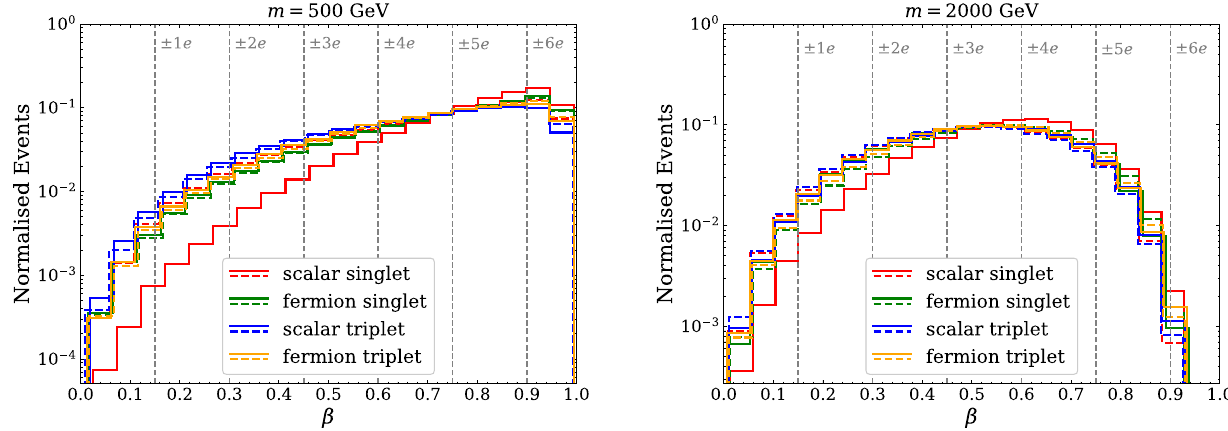
Fig. 8 Velocity distributions of multi-charged LLPs with mass 500 GeV (left) and 2 TeV (right). The solid and dashed histograms correspond to = 0 . 15 · | Q / e | , are depicted with the gray vertical dashed Q = 1 e and 8 e , respectively. MoEDAL’s detection thresholds, β thr Q